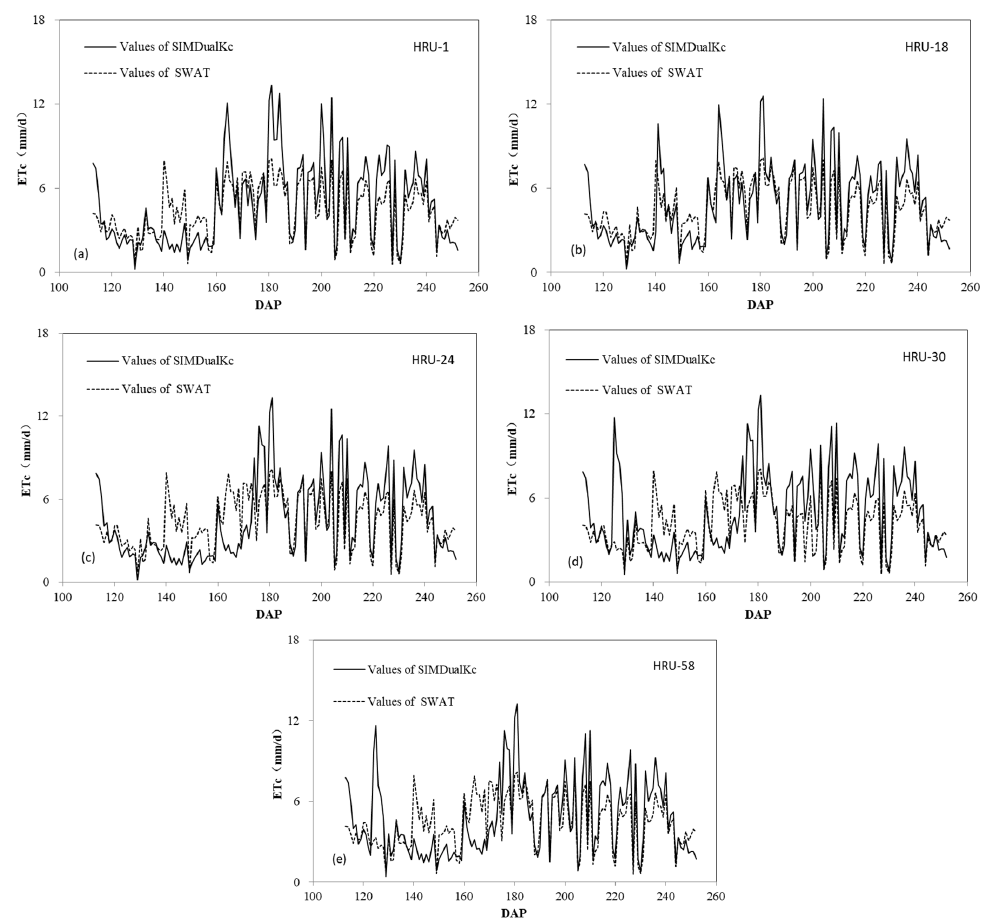
Figure 10. Variations in ET c simulated using SIMDualKc and SWAT (( a ) HRU-1; ( b ) HRU-18; ( c ) HRU-24; ( d ) HRU-30; and ( e ) HRU-58, which are used for calibration; DAP is day after planting).